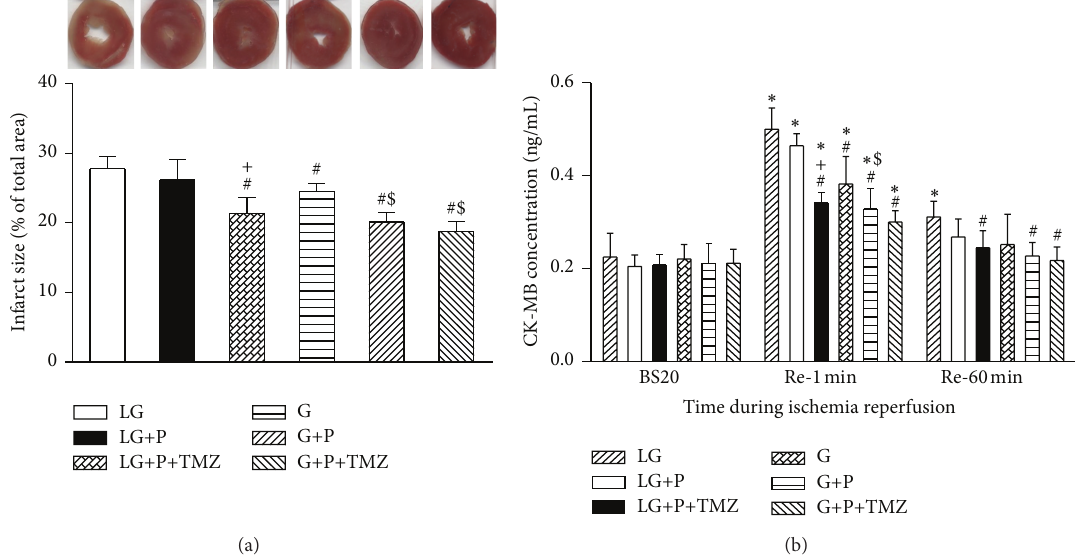
Figure 1: Effect of low glucose (LG) and glucose (G) on myocardial infarct size (IS) and CK-MB release during ischemia reperfusion. Rat hearts were randomly assigned to be perfused with glucose concentration at LG, LG+propofol (LG+P), and LG+propofol+trimetazidine (LG+P+TMZ) or with G, G+propofol (G+P), and G+propofol+trimetazidine (G+P+TMZ). Myocardial IS was measured by TTC staining. Myocardial IS and cardiac CK-MB release were significantly higher in LG than in G ( 𝑃 < 0.05 ). Propofol significantly reduced IS and CK-MB in G but not in LG. TMZ facilitated propofol induced IS and CK-MB reduction in LG but did not induce further propofol beneficial effects on G. BS20, Re-1, and Re-60 are abbreviations of 20 min after stabilization, 1 and 60 min after reperfusion, respectively. Values are presented as mean ± SEM. 𝑁 = 7 per group. ∗ 𝑃 < 0.05 versus BS20; # 𝑃 < 0.05 versus LG; + 𝑃 < 0.05 versus LG+P; $ 𝑃 < 0.05 versus G.